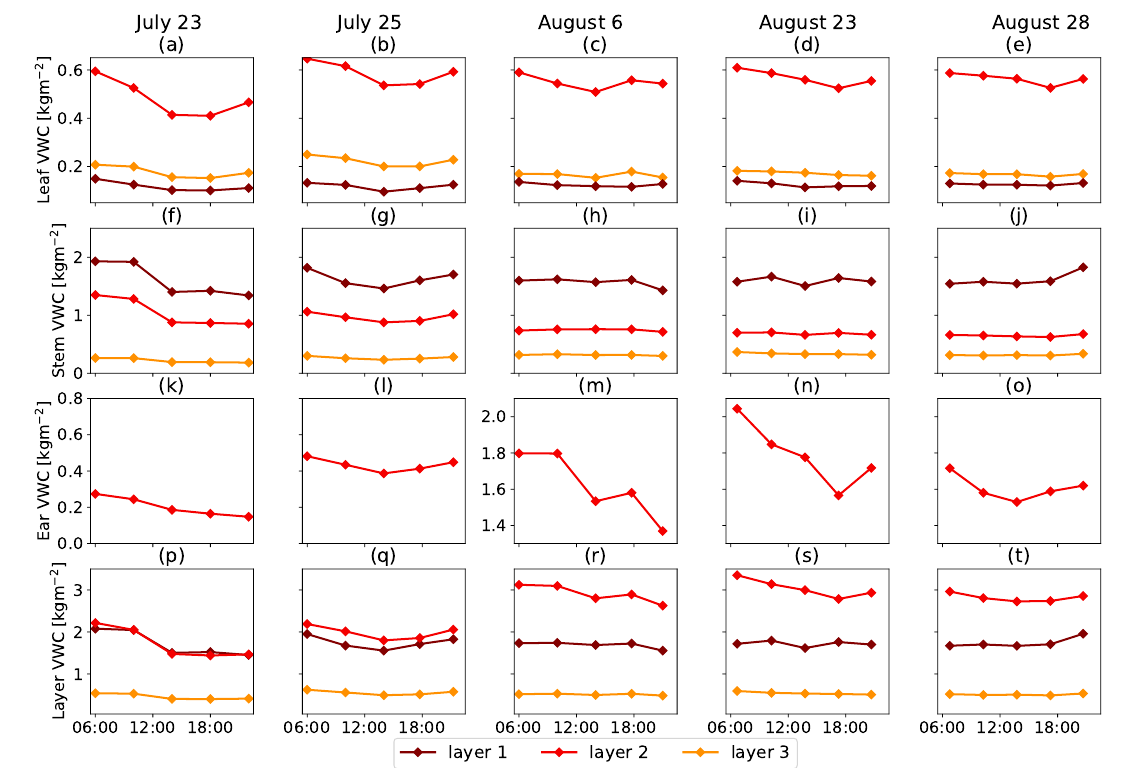
Figure 4. Five days of diurnal leaf ( a – e ); stem ( f – j ); ear ( k – o ); and layer ( p – t ); VWC variations in field corn [kg m − 2 ], and the difference between the three vertical layers in the canopy. Layer VWC is the sum of the moisture in all constituents within a certain layer. The sampling was performed five times between sunrise and sunset in the 2019